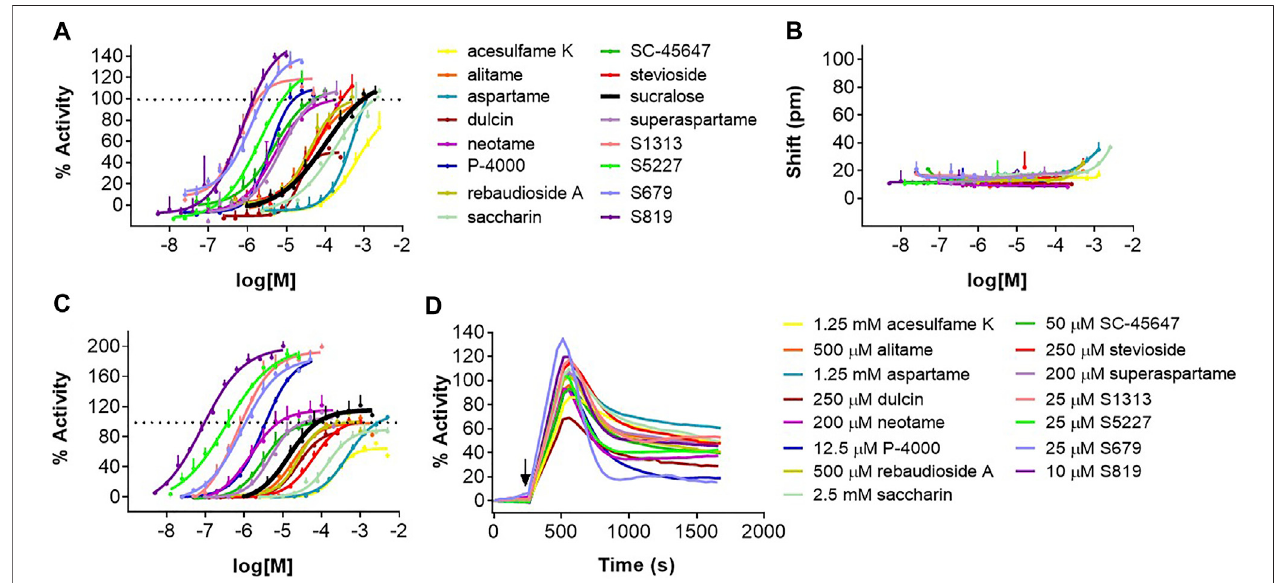
FIGURE4| Dose-response analysisofsweet taste receptor agonists inthe DMR and FLIPR assays. Agonists wereevaluated in theDMR assay withR2/R3 U2OS cells (A) and U2OS parental cells (B) and in the FLIPR assay with R2/R3 U2OS cells transduced with a Bacmam virus encoding G α 15 (C) as described in Materials and Methods . (D) Kinetics of indicated agonist responses in the DMR assay using R2/R3 U2OS cells. Dose-responses are representative of several independent experiments and each data point corresponds to an average and standard deviation of a triplicate determination.